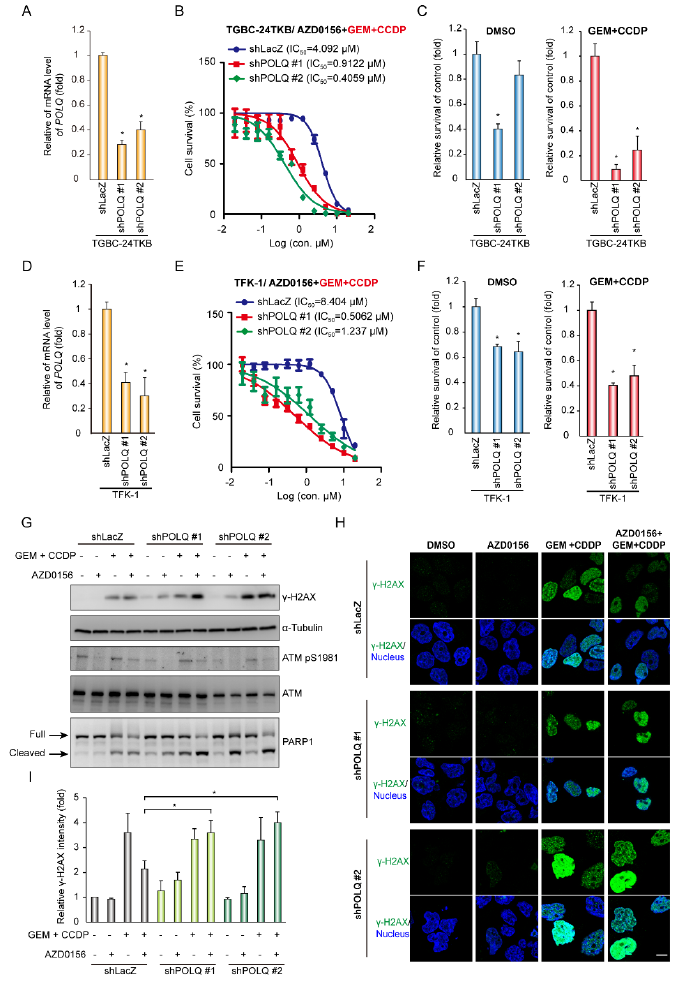
Figure 6. Knockdown of DNA polymerase θ improves AZD0156-mediated cell death. ( A ) DNA Figure 6. KnockdownofDNApolymerase θ improvesAZD0156-mediatedcelldeath. ( A ) DNA